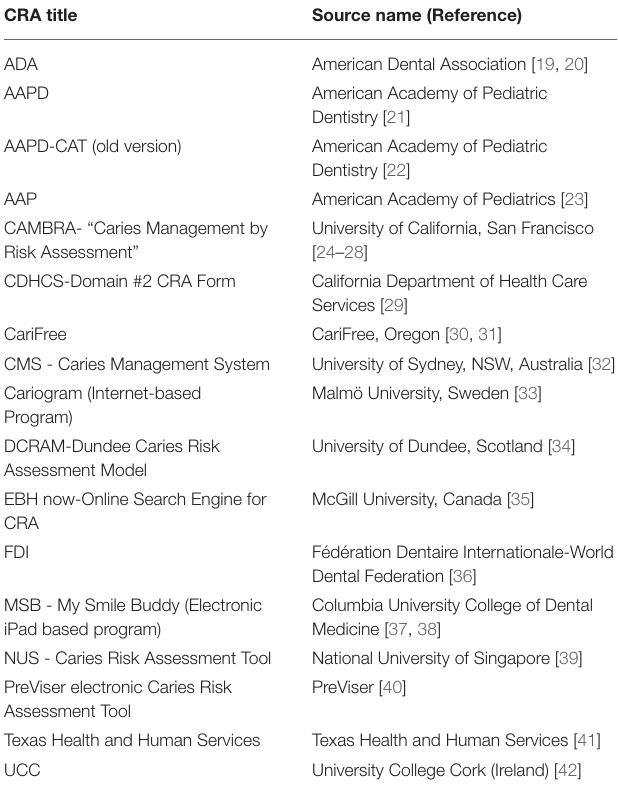
TABLE 1 | Caries risk assessment (CRA) tools-partial